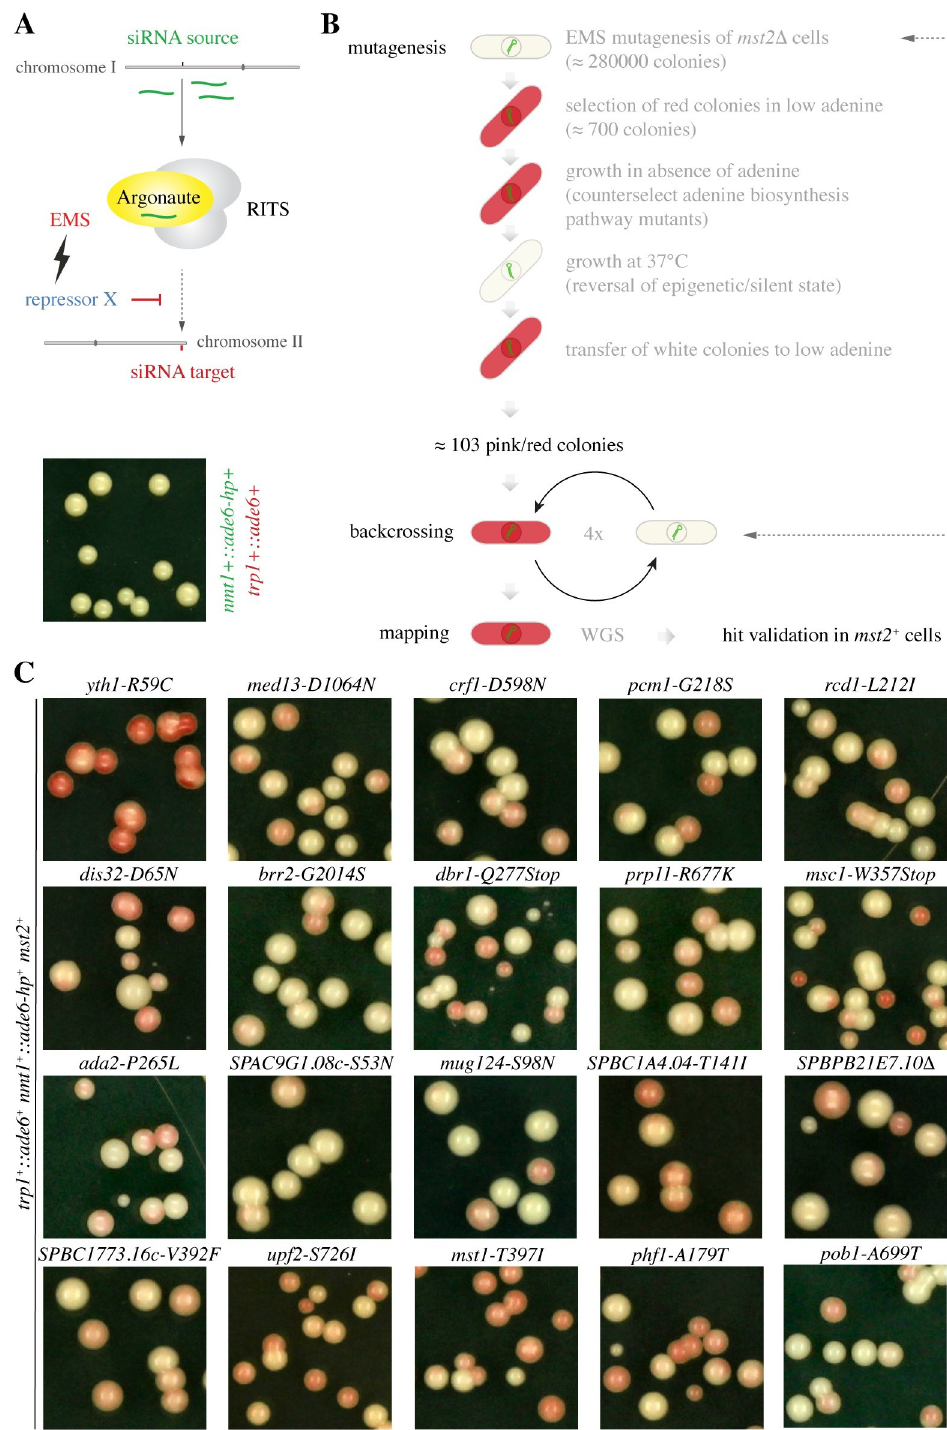
Fig 1. Enhancer screen to identify mutant alleles that enable small-RNA-mediated epigenetic gene silencing. (A) Schematic representation of the tester strains ( mst2 + or mst2 Δ ) used in this study. Primary ade6 siRNAs are produced from the nmt1 + locus on chromosome I (green). They can only induce silencing of the ade6 + reporter gene on chromosome II, if the tester strain acquires an enabling mutation (white color of the colonies shown indicates expression of the ade6 + reporter gene despite the presence of ade6 siRNAs in these cells). (B) Workflow of the EMS mutagenesis screen. For the initial screening, a mst2 Δ tester strain was used. Final hit validation was performed in